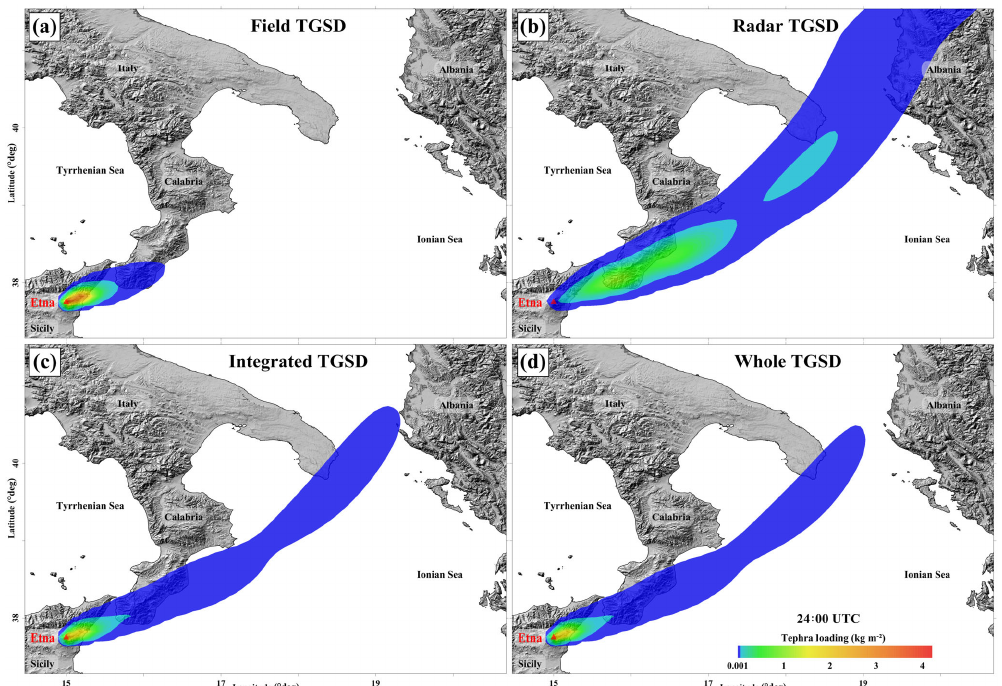
Figure 10. Tephra loading maps computed with the (a) Field, (b) Radar, (c) Integrated, and (d) Whole TGSDs, respectively. They indicate the relevance of the integrated approach reproducing the affected